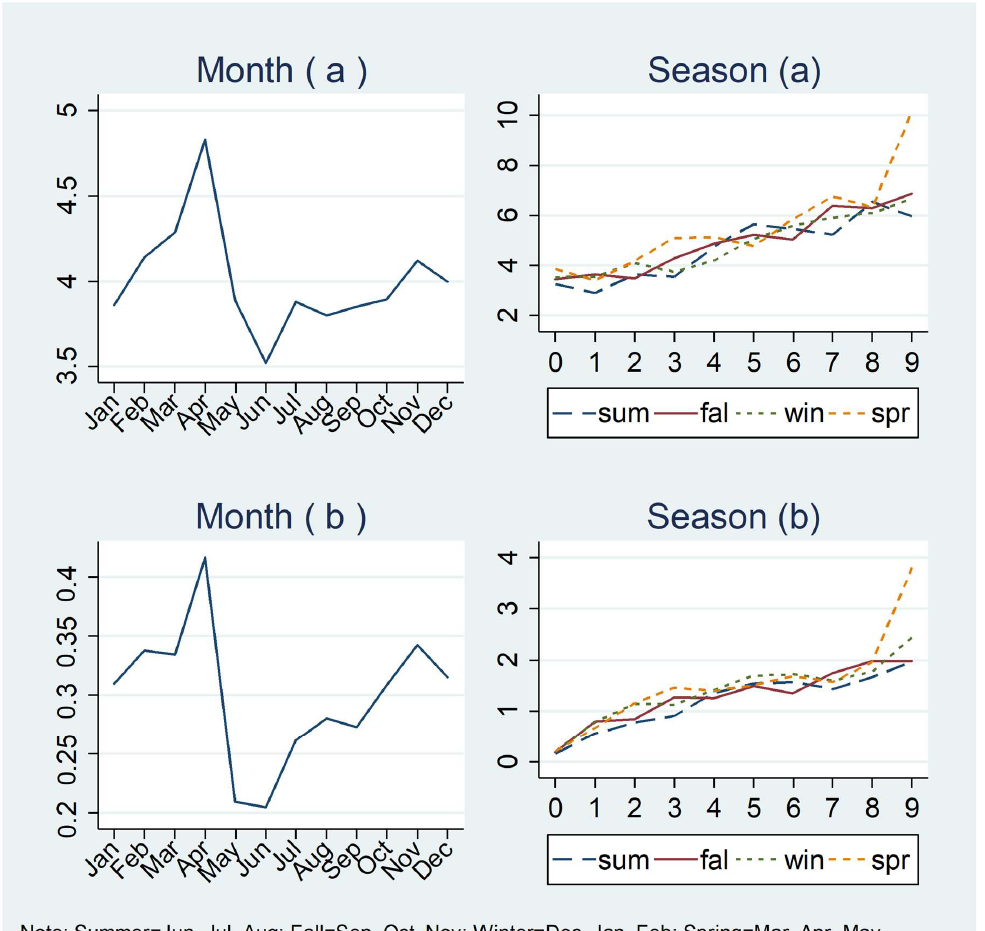
Figure 7. Average monthly ridesharing use varying by month and season for those who use ridesharing in the past 30 days: ( a ) 1–99 times; ( b ) 0–99 times.